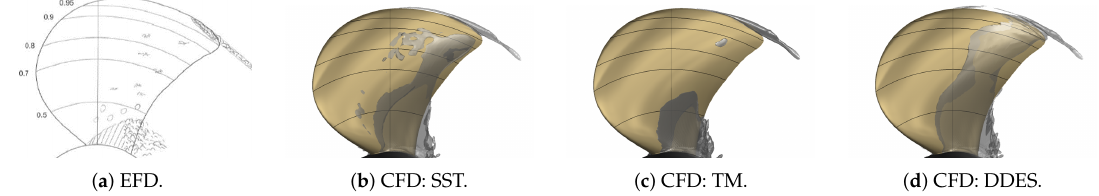
Figure 8. Comparison of model-scale near-blade cavitation observation for the PPTC Case 2. The EFD result is given in [26], and reproduced with permission from Lars Lübke (SVA).